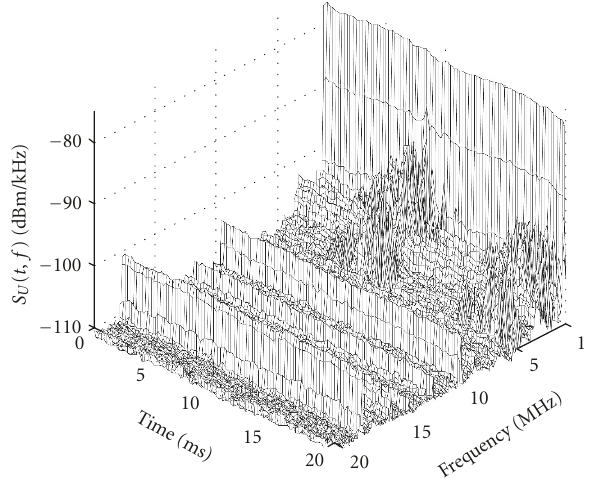
Figure 3: Oscillator and aperture phase noise